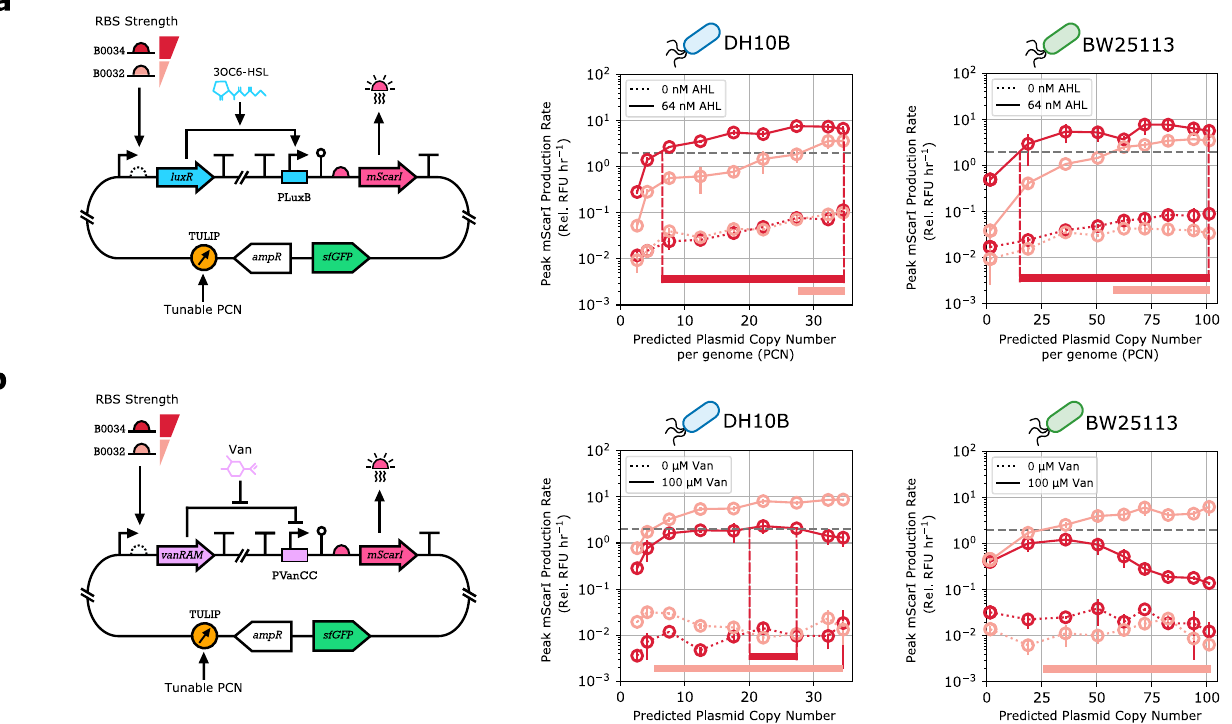
Fig. 6 | TULIP enables the re-use of modules in different contexts via fl exible PCN control. Gene expression wasquanti fi edinamicroplate reader.Inductionvia AHL (64nM) or Van (100 μ M) corresponds to the ON state, OFF state refers to the absence of these inducers. Cuminic acid induction levels are 0.4, 0.8, 1.2, 1.6, 2.0, 2.4,3.0,4.0,and5.0 μ M;thevaluesforPCNaredeterminedbythe fi tsgeneratedin Fig. 3b between Cuminic acid concentration and PCN quanti fi ed by qPCR. Pro- duction of mScarI is normalized to DHScarI and BWScarI, respectively, which are strains constitutively expressing mScarI, thus mScarI production is reported as a